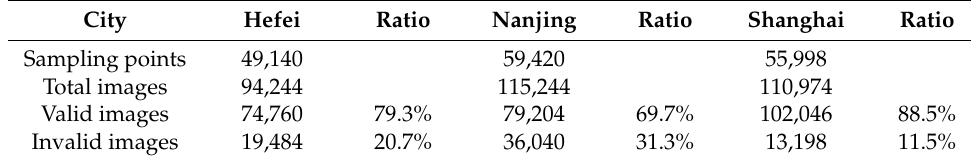
Table 2. Valid street view image